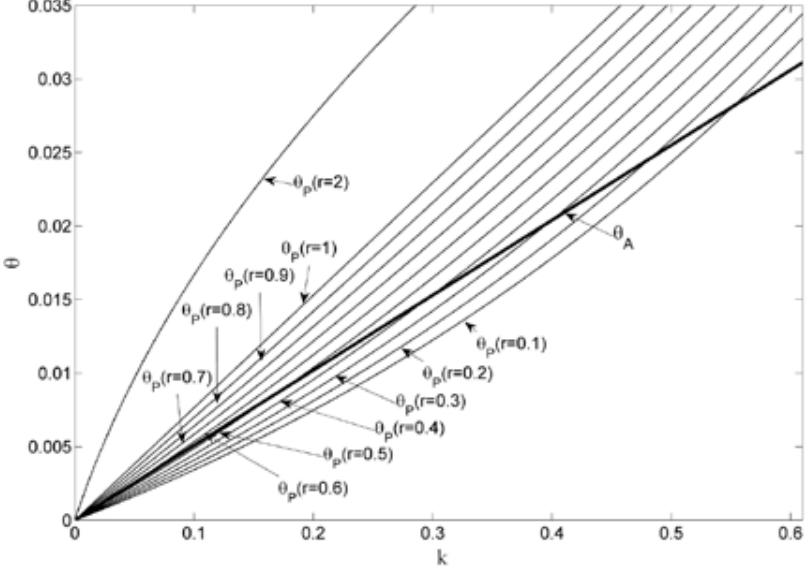
Figure 2. Development of compensations depending on